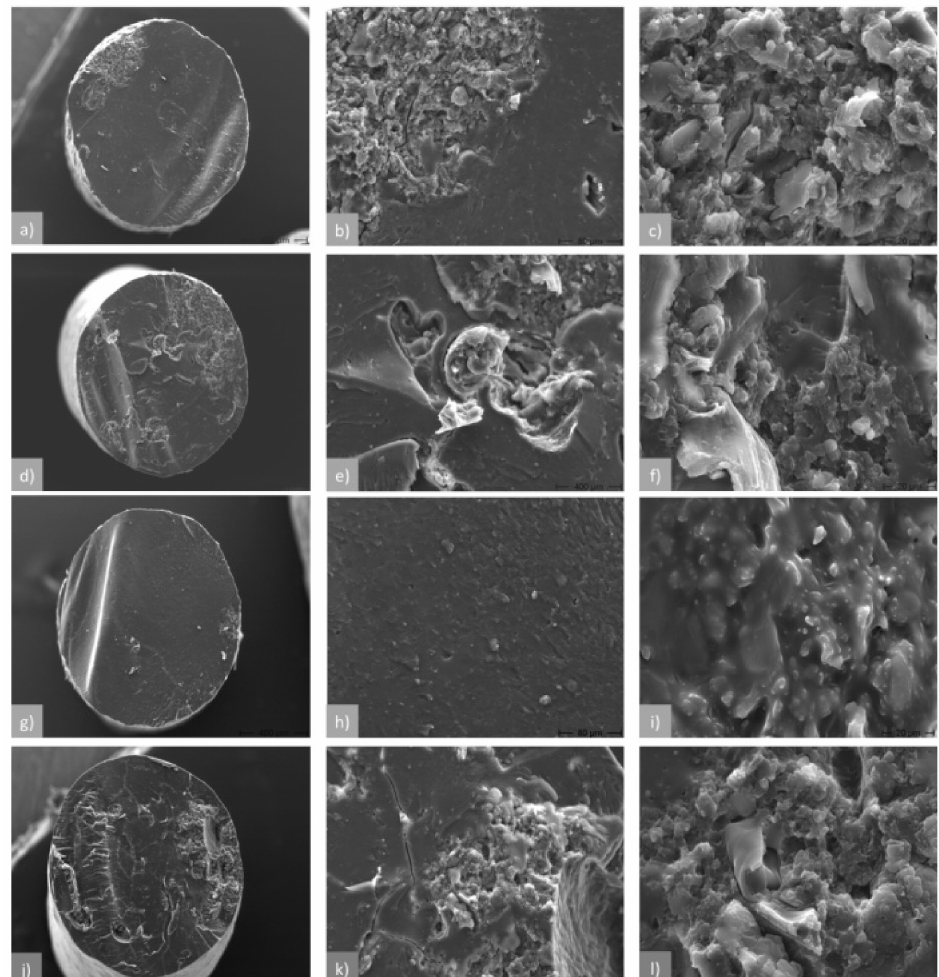
Figure 5. Cross-section of instant rice pasta processed at variable moisture content and screw speed: ( a – c ) 28%, 60 rpm; ( d – f ) 30%, 60 rpm; ( g – i ) 30%, 80 rpm; ( j – l ) 32%, 100 rpm; magnifications × 125 (left column), × 600 (middle column), and × 2000 (right